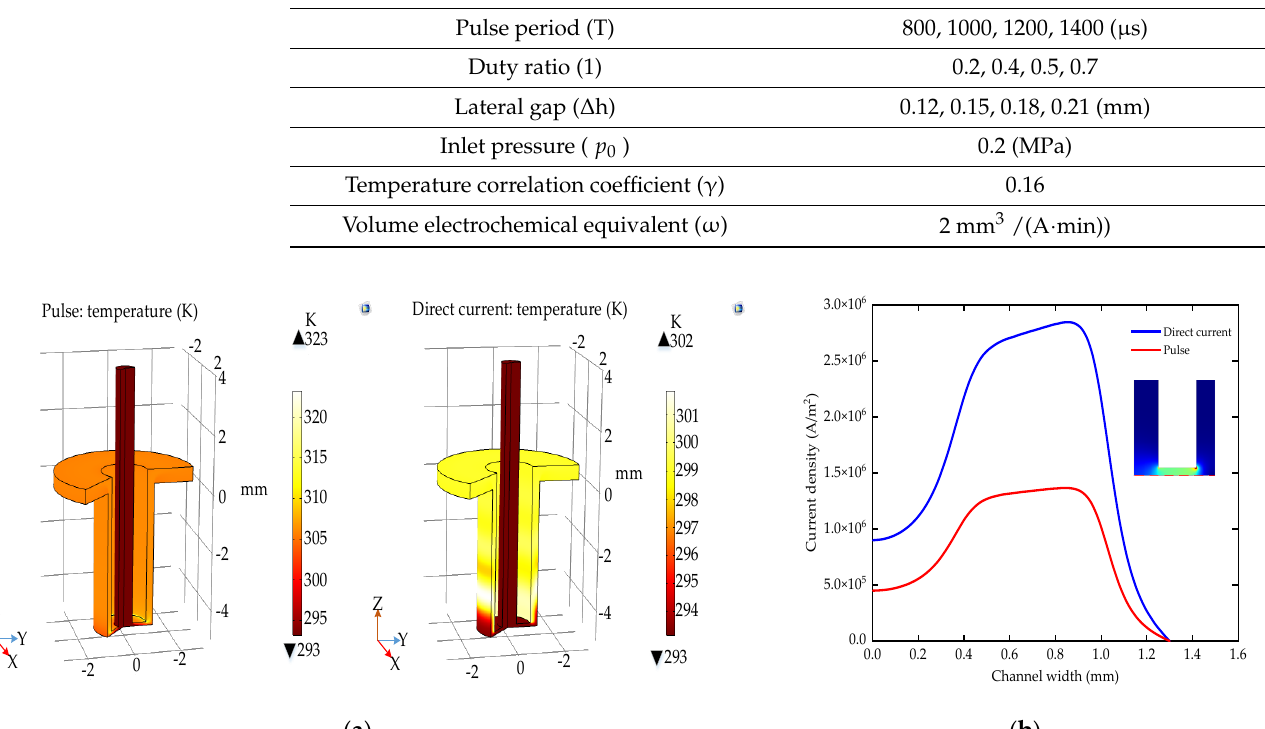
Figure 4. The temperature and current density with different power supply; ( a ) the temperature of the machining area; ( b ) the current density on the anode surface.